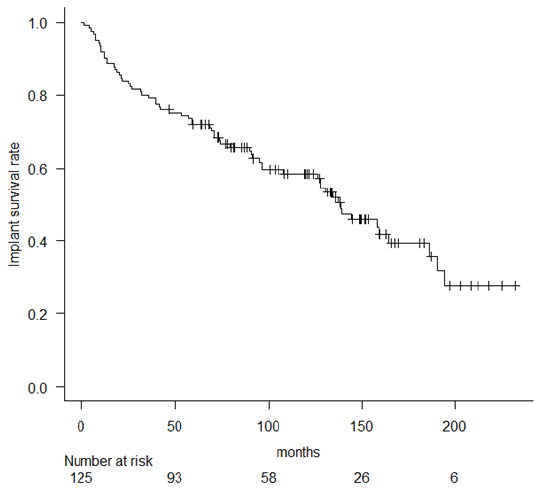
Figure 2. Kaplan–Meier curve showing implant survival rate. All causes of implant failure are in- cluded.